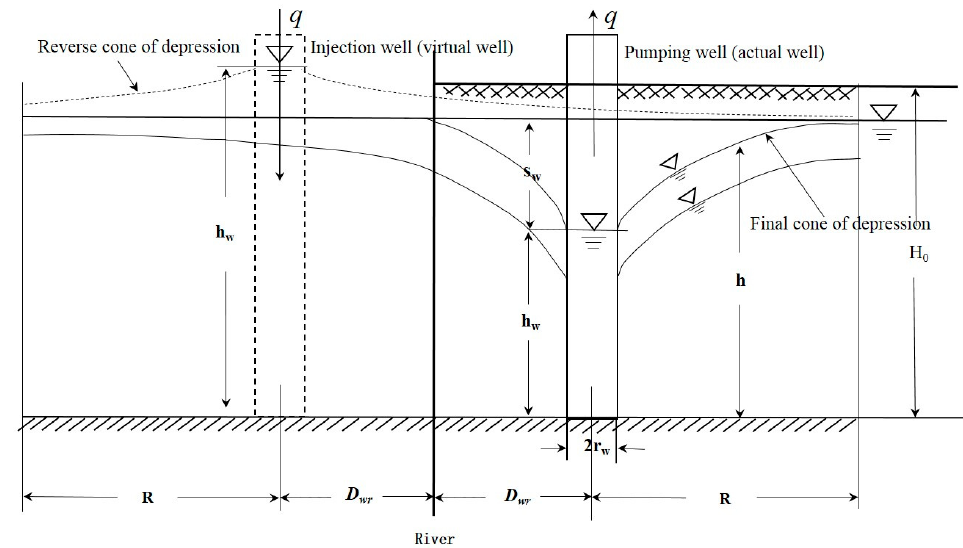
Figure 1. Diagram of the Mirror-Image method for a specified-head recharge boundary (river in special).